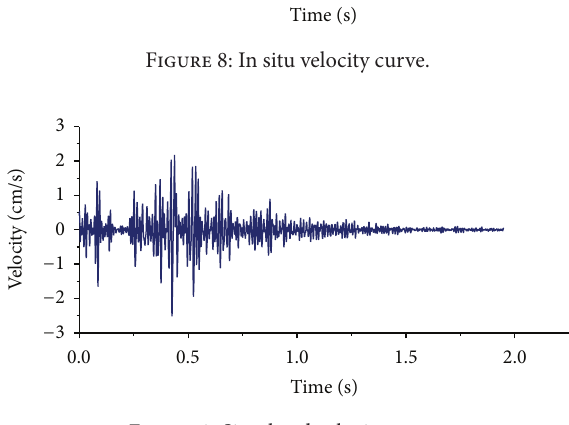
Figure 8: In situ velocity curve.